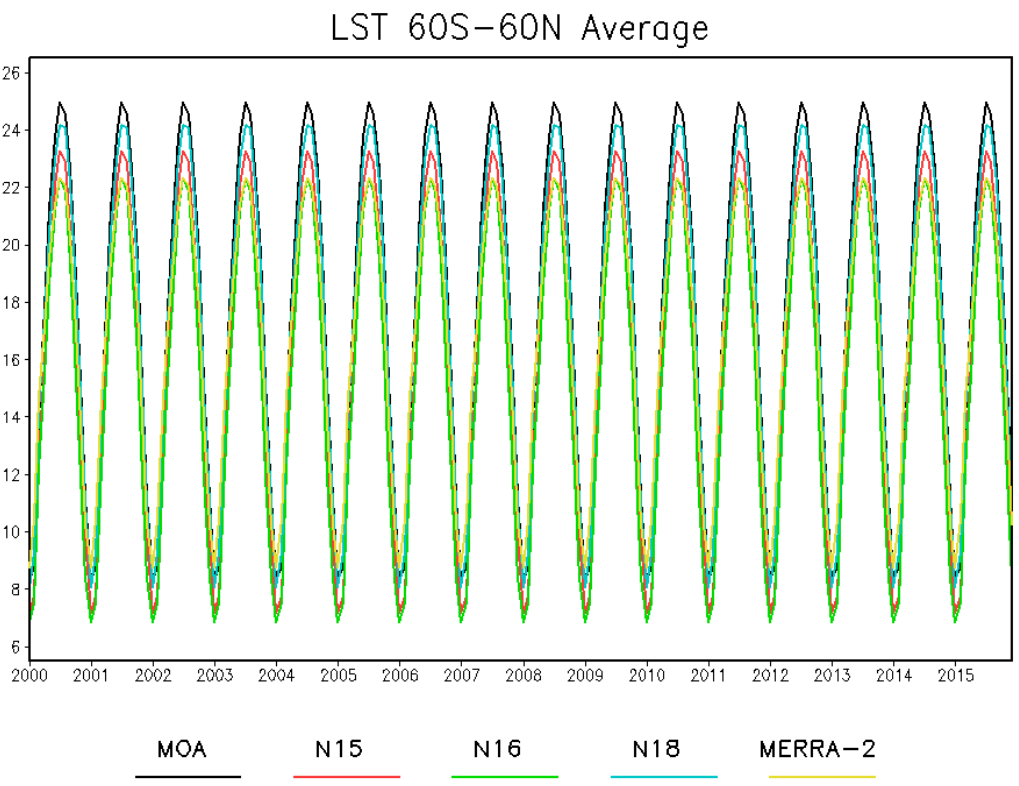
Figure 8. Time series of monthly mean LST (deg C) for each satellite in the HBC and MERRA-2 for the band between 60°S and 60°N.